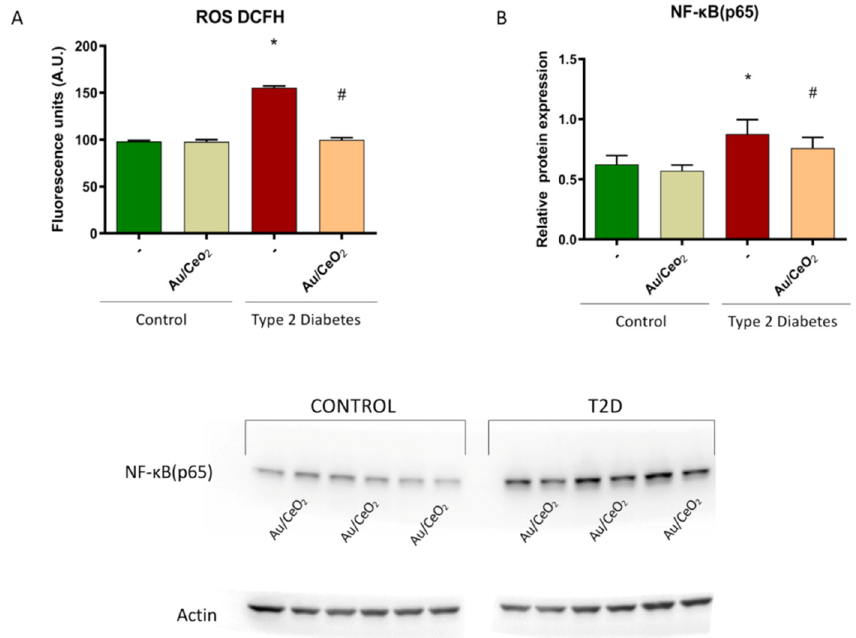
Figure 9. ( A ) ROS production evaluated by DCFH-DA, ( B ) levels of NF- κ B (p65) treated or not with Au/CeO 2 (3 h, 0.02 mg/mL) in leukocytes from type 2 diabetic patients and control subjects and ( C ) representative WB image. * p < 0.05 vs. control group. # p < 0.05 vs. T2D group (original WB are shown in Supplementary Figure S1).